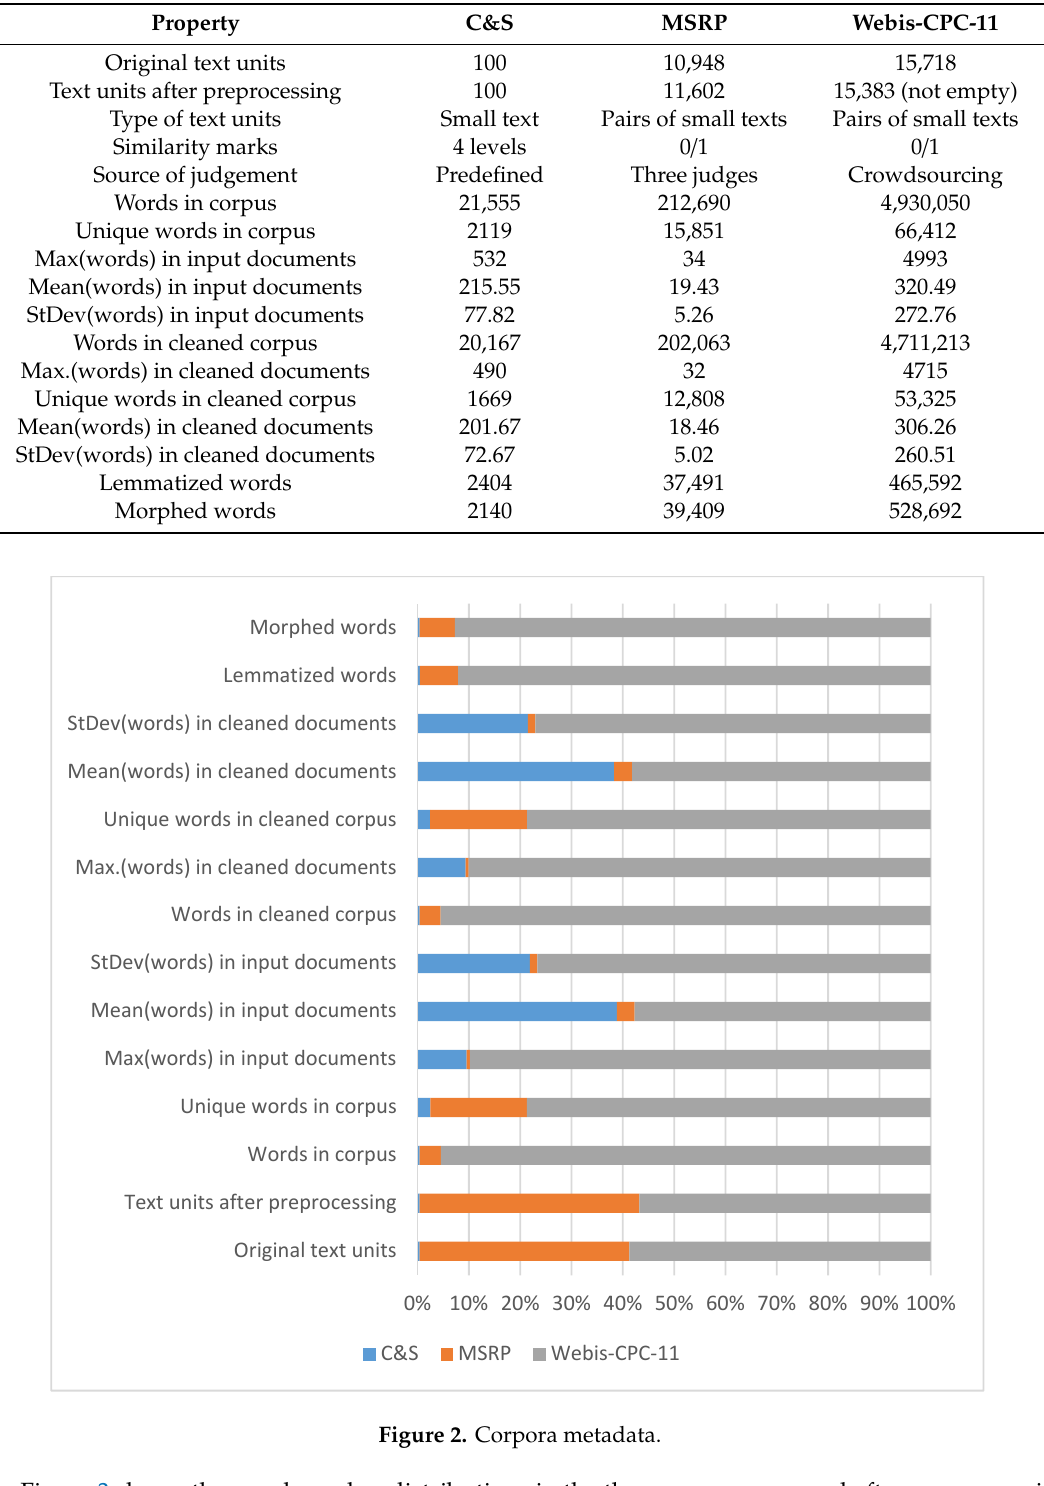
Table 1. Corpora metadata.